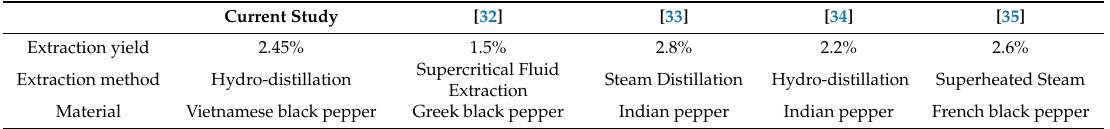
Table 4. Comparison of black pepper oil yields from different studies.